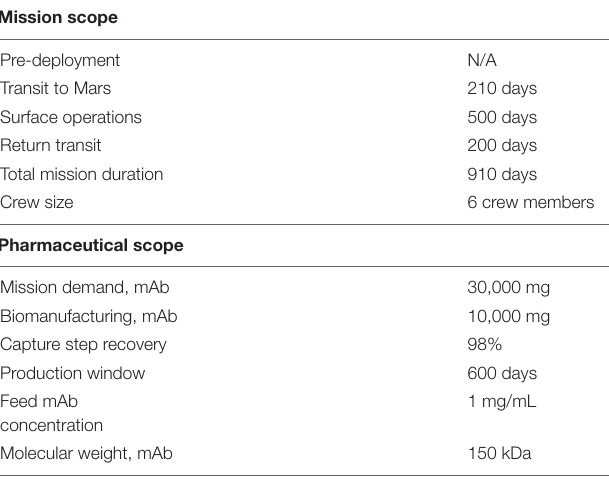
TABLE 2 | Key mission and pharmaceutical reference mission architecture details and